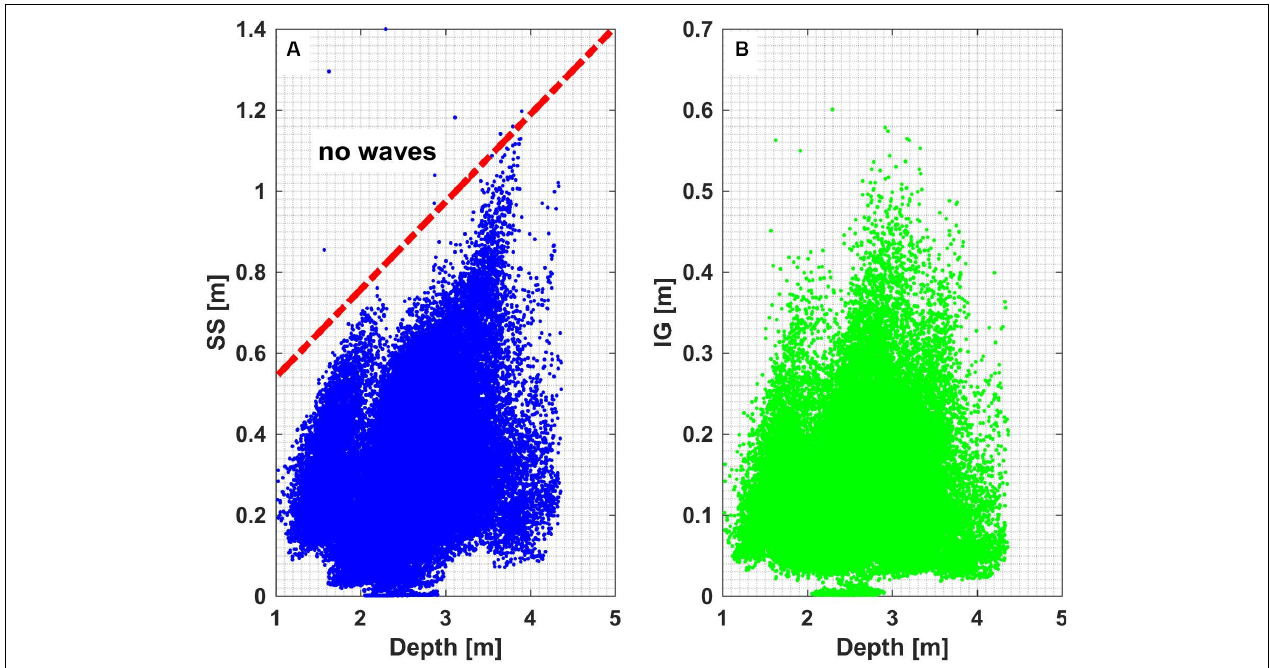
FIGURE 6 | Correlation between water depth and (A) sea-swell significant wave heights as well as (B) infragravity significant wave heights at all observed points inside the lagoon. The red dashed line in (A) represents a sea-swell wave height to depth ratio ( γ ) of 0.39.